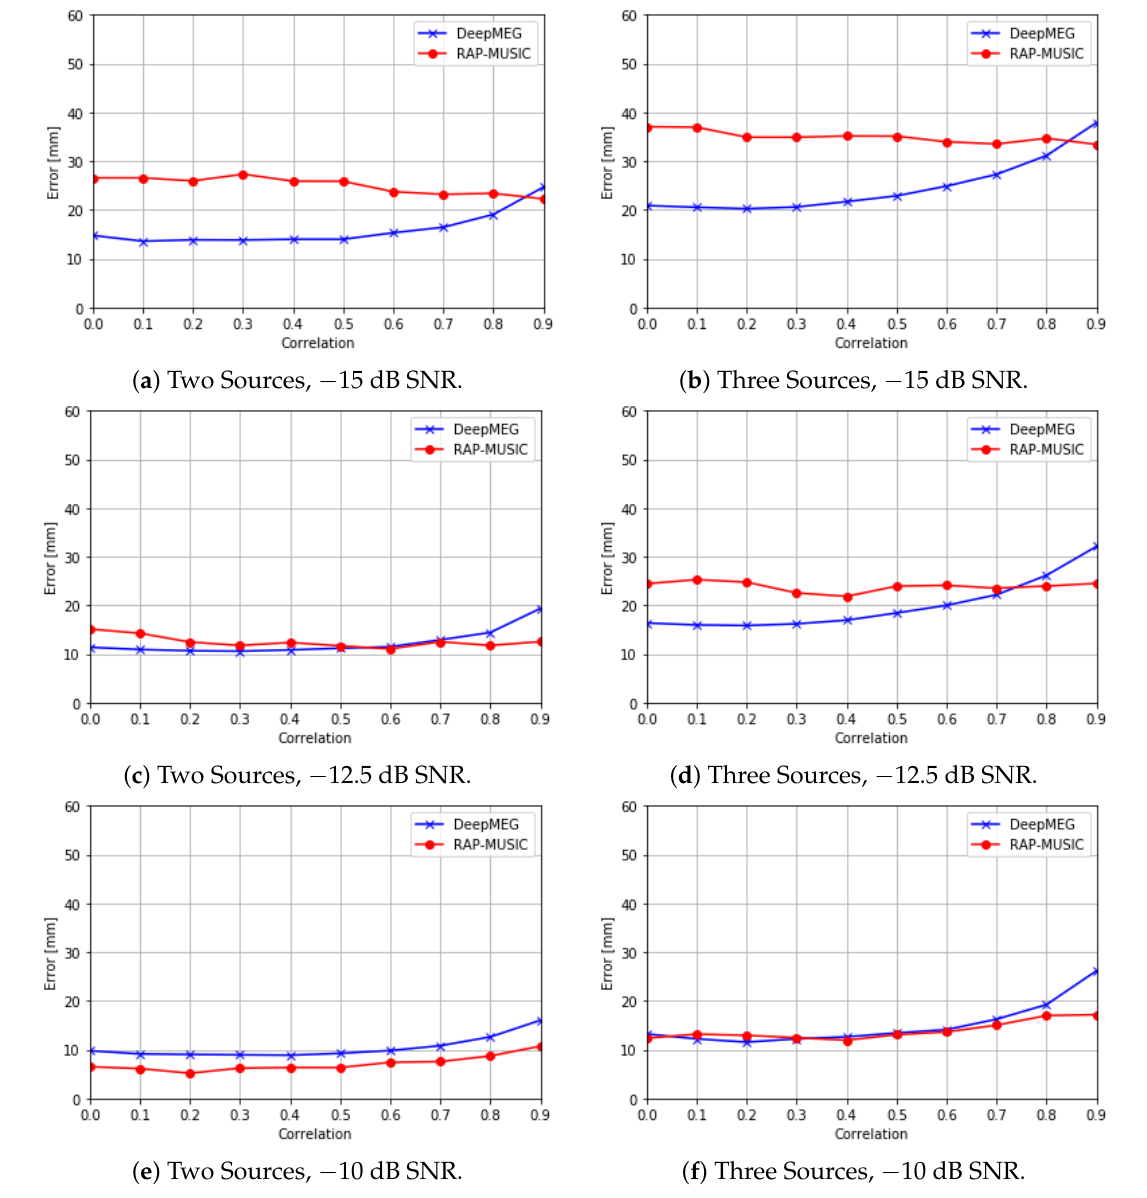
Figure 6. Localization accuracy of the DeepMEG-CNN model with T = 16 time samples at different inter-source correlation values for the cases of two and three sources with − 15 dB, − 12.5 dB and − 10 dB SNR